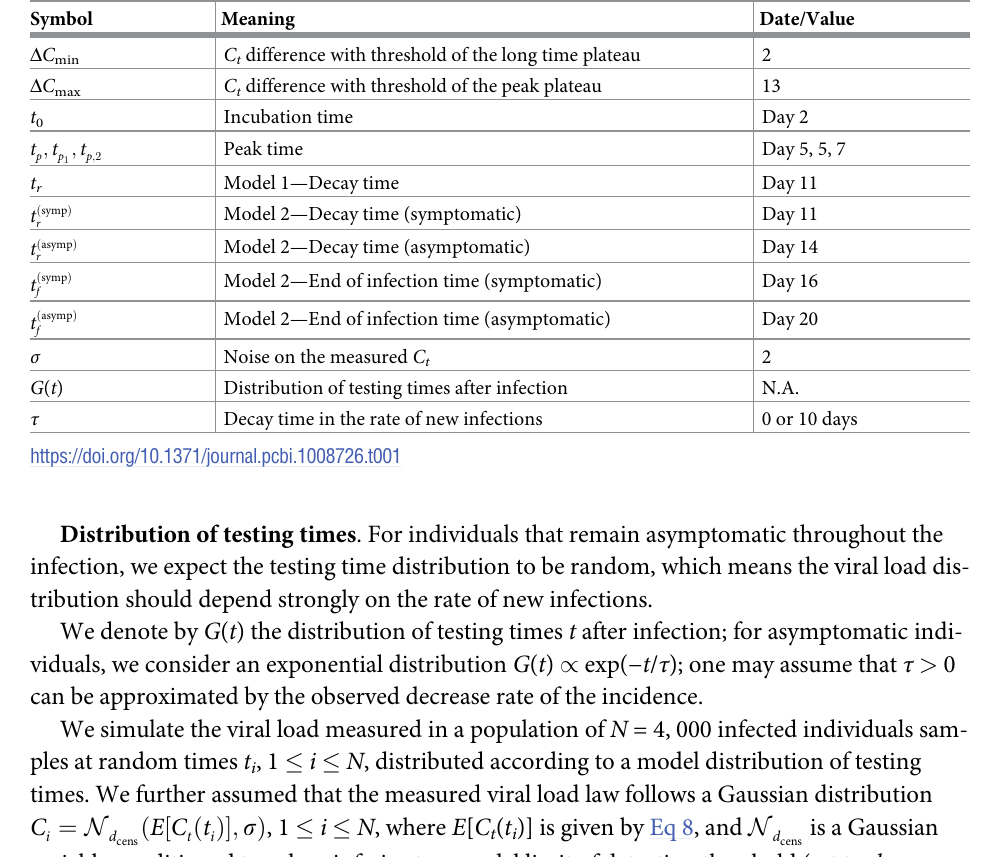
Table 1. Table of values used in Fig 3 for our viral load evolution models. Symbol